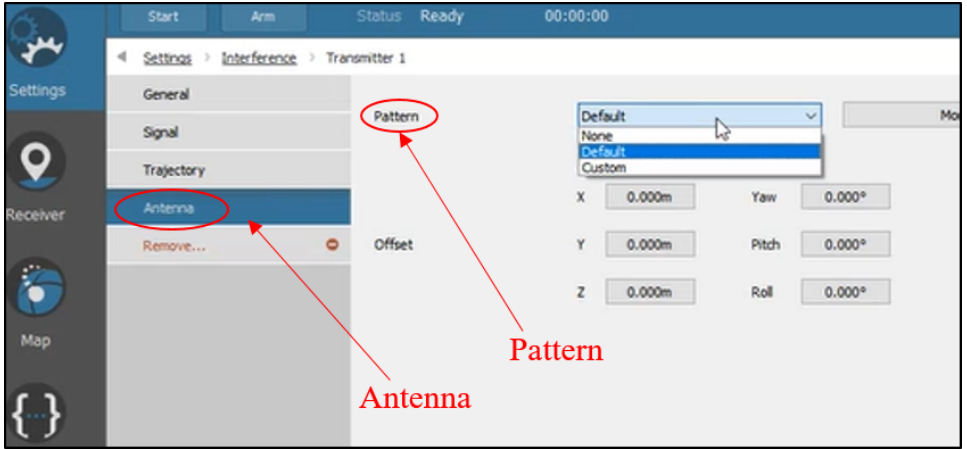
Figure 5. Specifying antenna pattern.